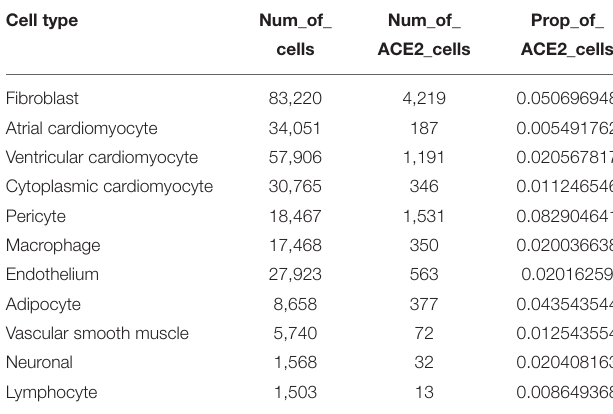
TABLE 2 | The expression features of angiotensin-converting enzyme 2 (ACE2) in the human heart. Cell